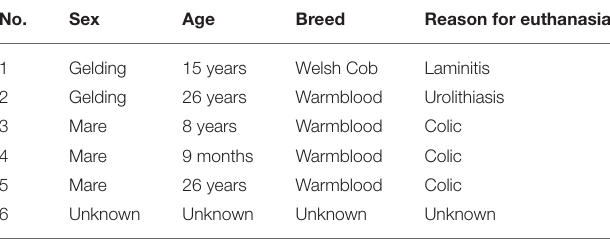
TABLE 1 | Data of horses